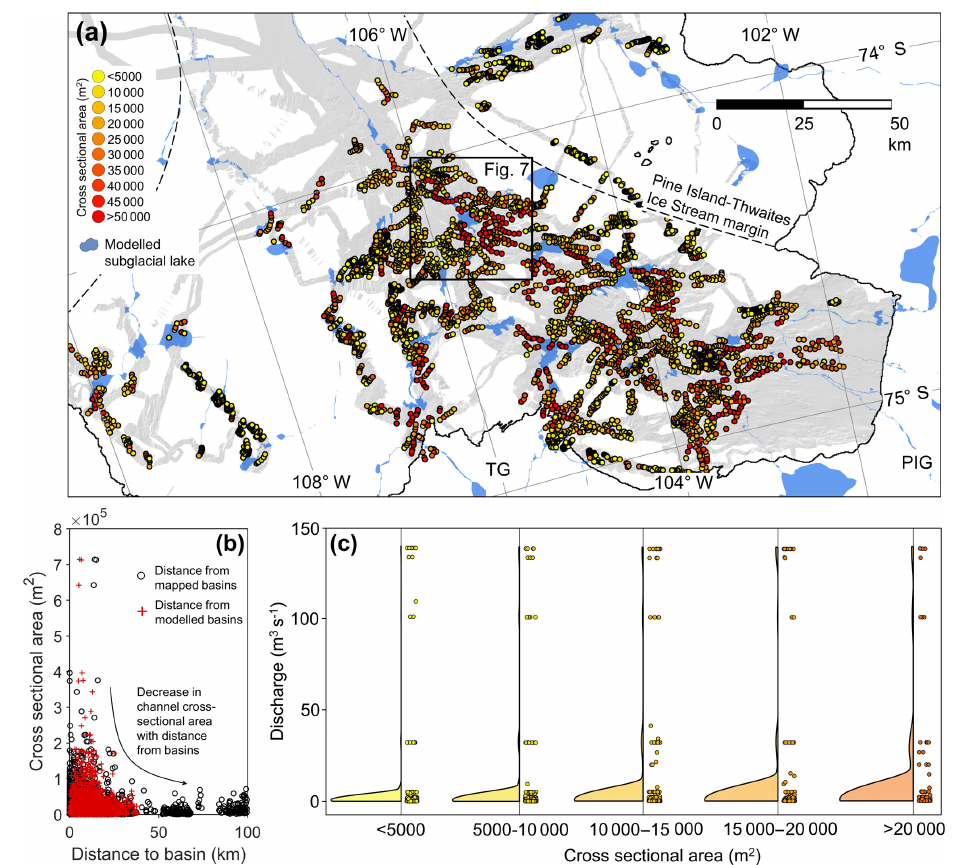
Figure 6. Spatial variation in channel size within Pine Island Bay. (a) Spatial variation in channel cross-sectional area in relation to the location of modelled subglacial lakes. Channel cross sections used to analyse channel geometry are displayed as dots coloured by channel cross-sectional area. The margins of the former Pine Island–Thwaites Ice Stream (Graham et al., 2010) and the location of Fig. 7 are shown. The present-day ice margin from LIMA (U.S. Geological Survey, 2007) is displayed as a solid black line. (b) Variation in channel cross- sectional area with distance to the nearest mapped and modelled subglacial lake basin. (c) Rain cloud plot showing the data and distributional shape of modelled steady-state discharges through channels of different cross-sectional areas. Rain clouds were produced using code from Allen et al.